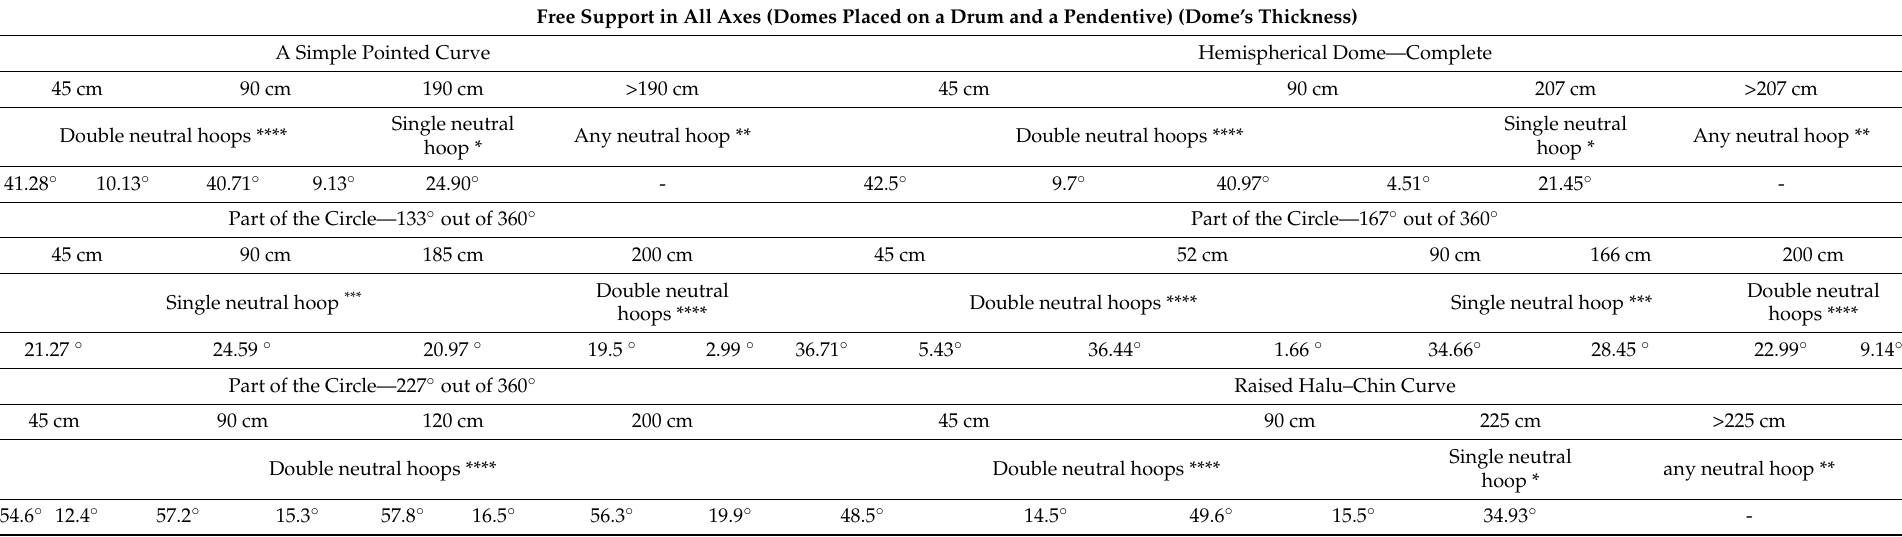
Table 11. Analysis of domes with various thicknesses—R m = 5 m, H drum = 3 m, t drum = 1.1 × t dome , R drum = 5 m, R drum with pendentive = 6